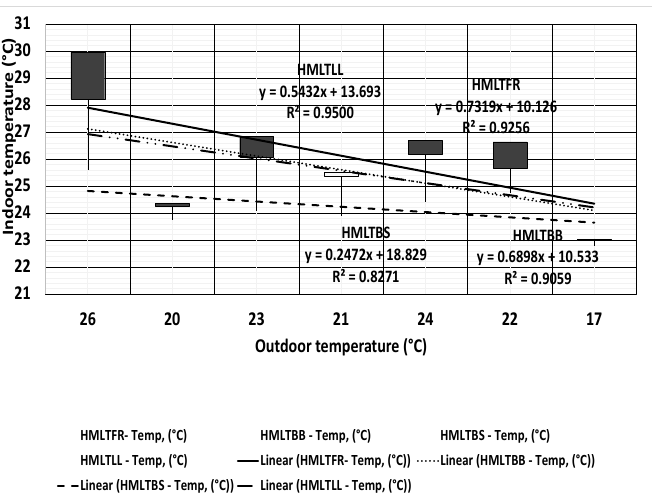
Figure 4. Range of the mean indoor temperatures compared with the mean outdoor temperatures.